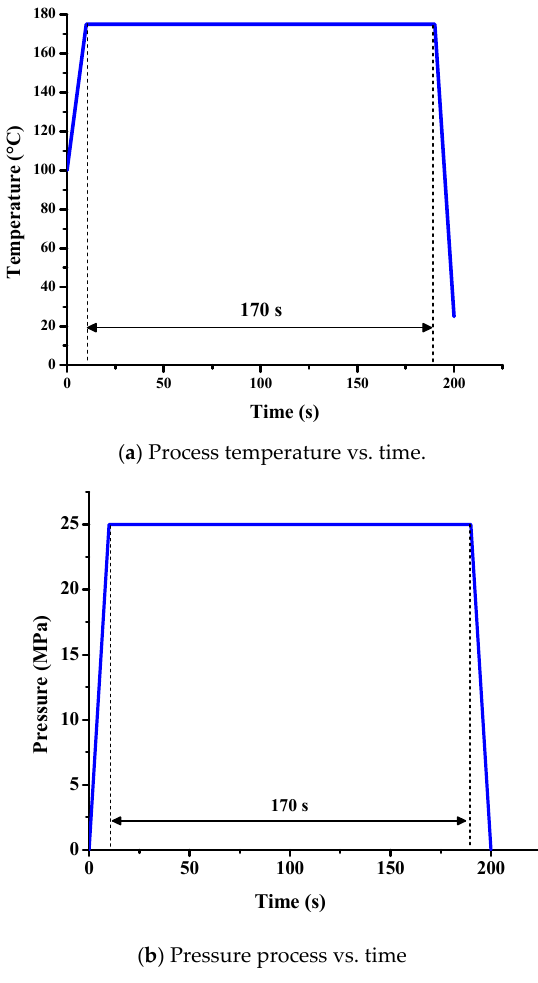
Figure 9. Parameters of ( a ) process temperature and ( b ) pressure for simulation.